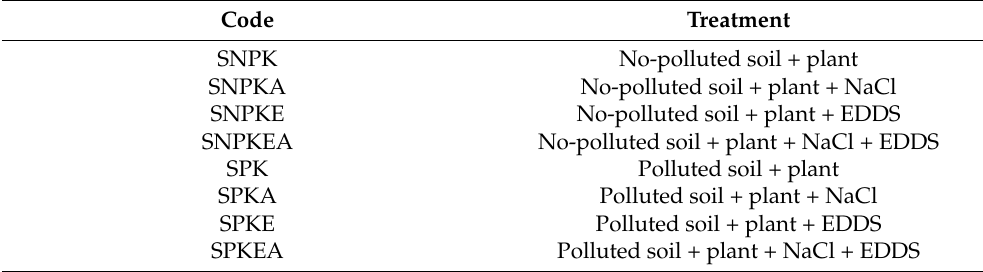
Table 8. Code and treatment of the experiment on K. pentacarpos subjected to pollution of heavy metal and the presence and absence of EDDS or/and